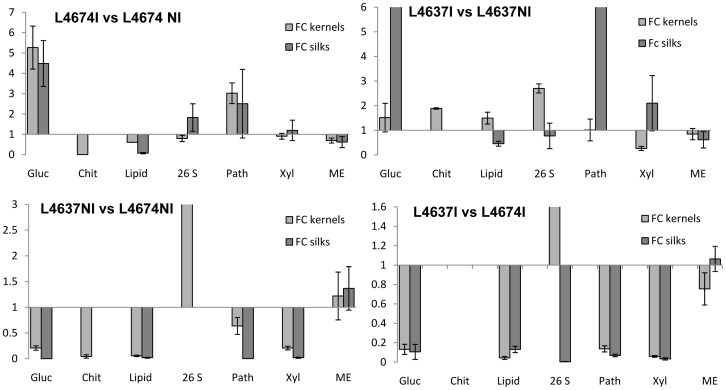
Silk gene expression analyses by qRT-PCR of seven selected genes.Gluc: glucanase, chit: chitinase, Lipid: Nonspecific lipid-transfer protein, 26S: 26S proteosome, Path: pathogen related protein, Xyl: xylanase inhibitor, ME: malic enzyme, FC: fold change gene expression.